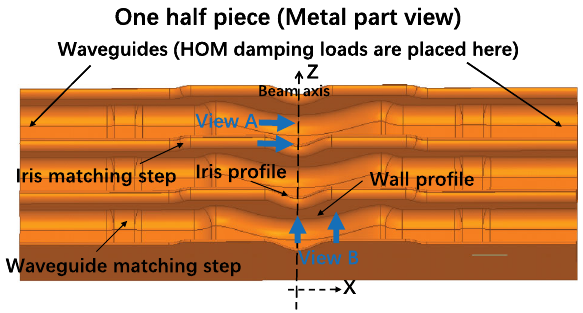
FIG. 4. New open geometry structure with full damping scheme.